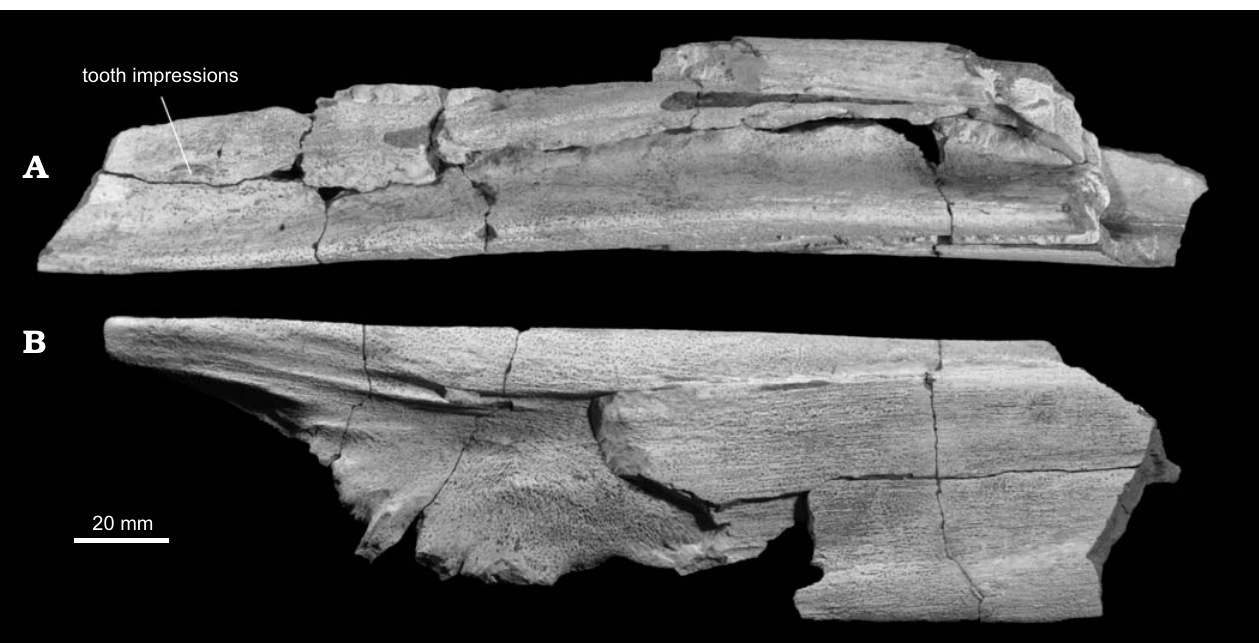
Fig. 3. Rostrum fragment of ophthalmosaurid ichthyosaur Cryopterygius kielanae sp. nov. (GMUL 3579-81, holotype) from the Late Jurassic of Owadów- Brzezinki Quarry; in “dental/apical” ( A ) and right-lateral ( B ) views. Table 1. Selected skeleton measurements (in mm) of Cryopterygius kielanae sp. nov. (GMUL 3579-81,